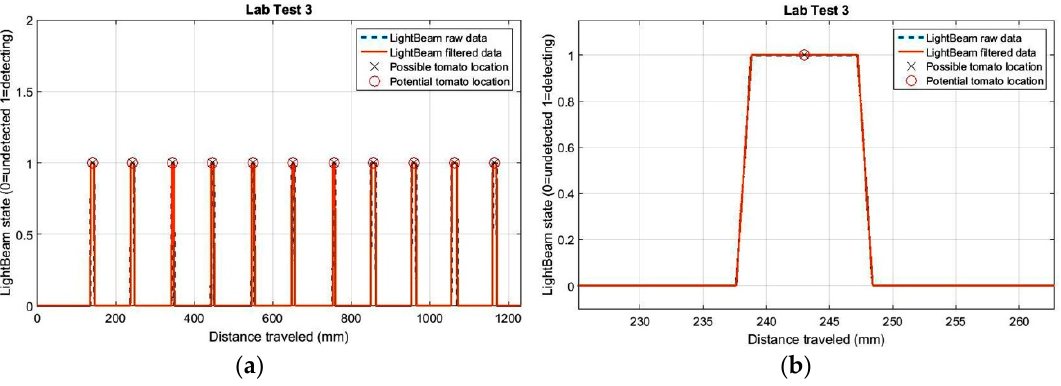
Figure 6. ( a ) Positions of the stems of the 11 plants in the laboratory test; ( b ) Average plant position for a distance of 11 mm.